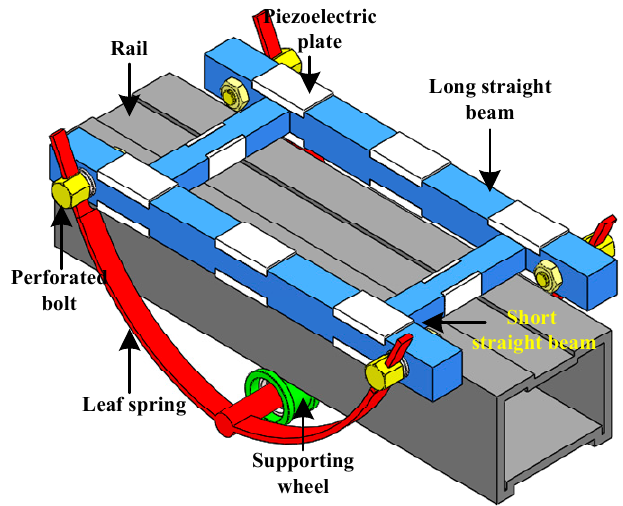
Figure 1. Configuration of the proposed framed piezoelectric actuated railed carrying system.